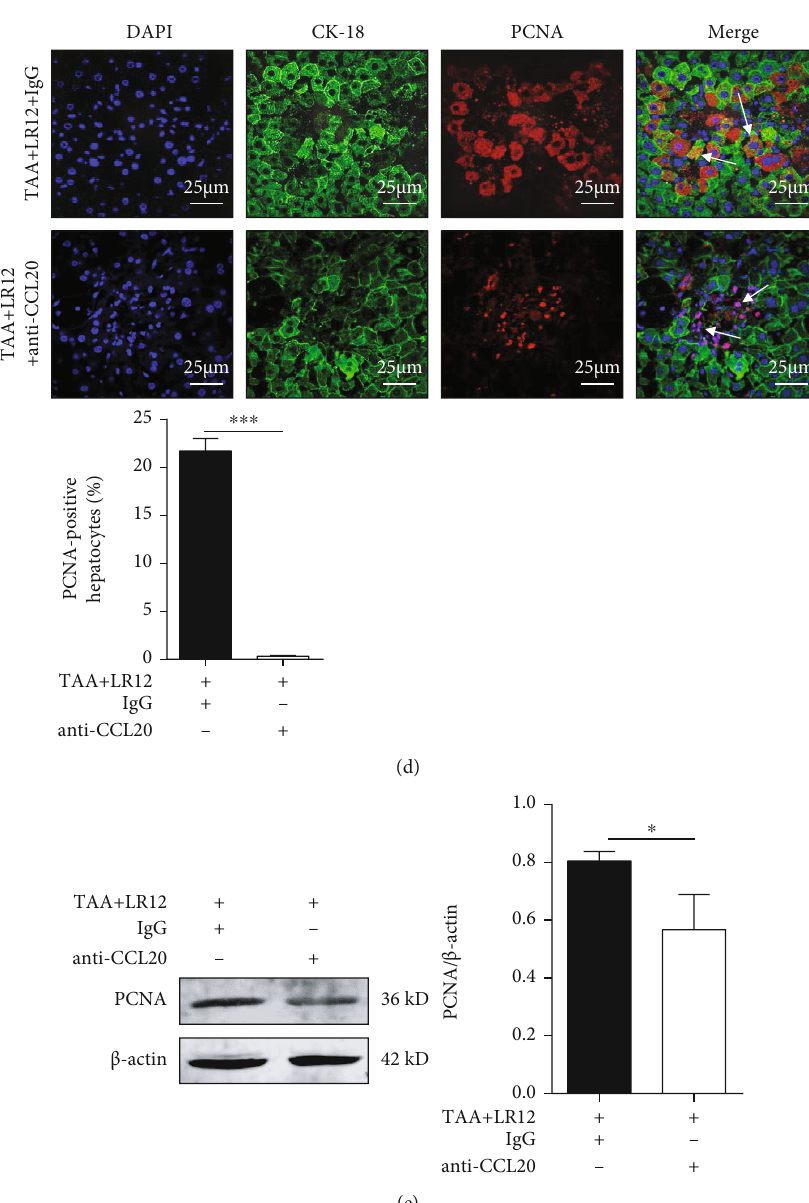
Figure 6: CCL20 neutralization aggravated the severity of TAA-induced ALF and inhibited liver regeneration. (a) Western blot analysis of PCNA in LO2 cells stimulated with TAA+LR12 or/and anti-CCL20 hAbs. (b) H&E staining (magni fi cation, 400x) of the liver tissues in mice treated with TAA+LR12 and normal rat IgG or anti-CCL20 mAbs. (c) The levels of alanine aminotransferase (ALT) and aspartate aminotransferase (AST) in serum. (d) CLSM showing CK18 and PCNA staining in the liver tissues in mice treated with TAA+LR12 and normal rat IgG or anti-CCL20 mAbs. (e) Western blot analysis of PCNA in the liver tissues. Data were presented as the mean ± standard deviation (SD). ∗ P < 0 : 05 , ∗∗ P < 0 : 01 , and ∗∗∗ P < 0 : 001 versus control